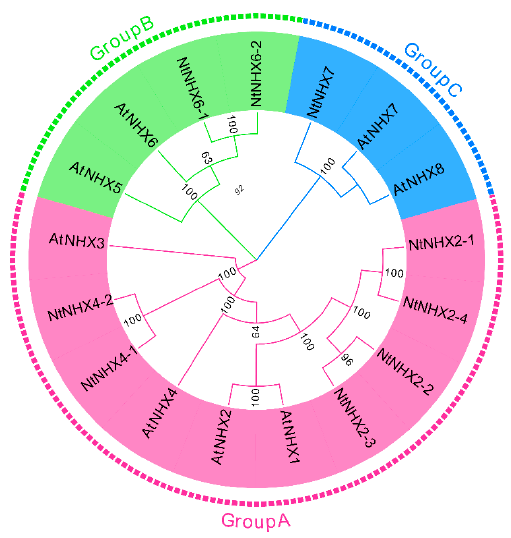
Figure 11. Phylogenetic analysis of NHX genes in Nitraria tangutorum and Arabidopsis thaliana (Linn.) Heynh.